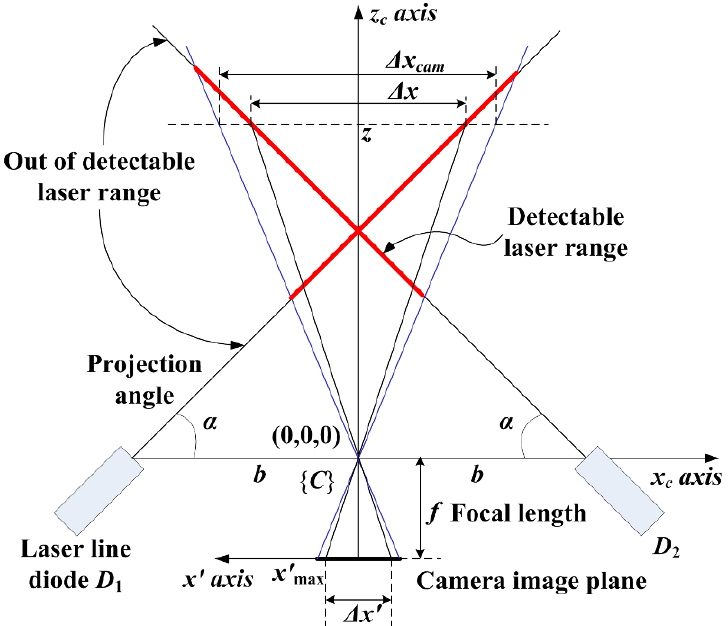
axis according to the depth z c